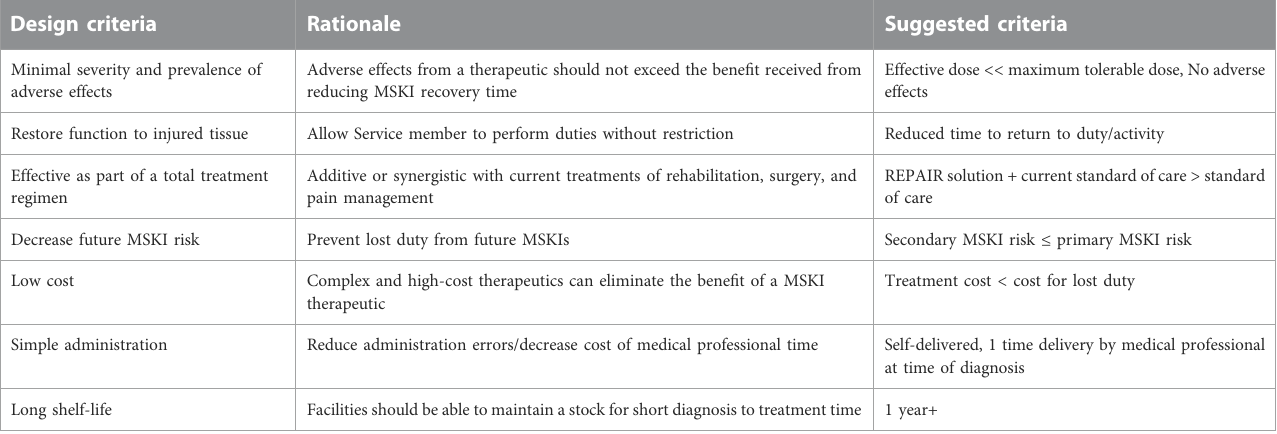
TABLE 2 Suggested design criteria for REPAIR solutions. Design criteria Rationale Suggested criteria Minimal severity and prevalence of adverse